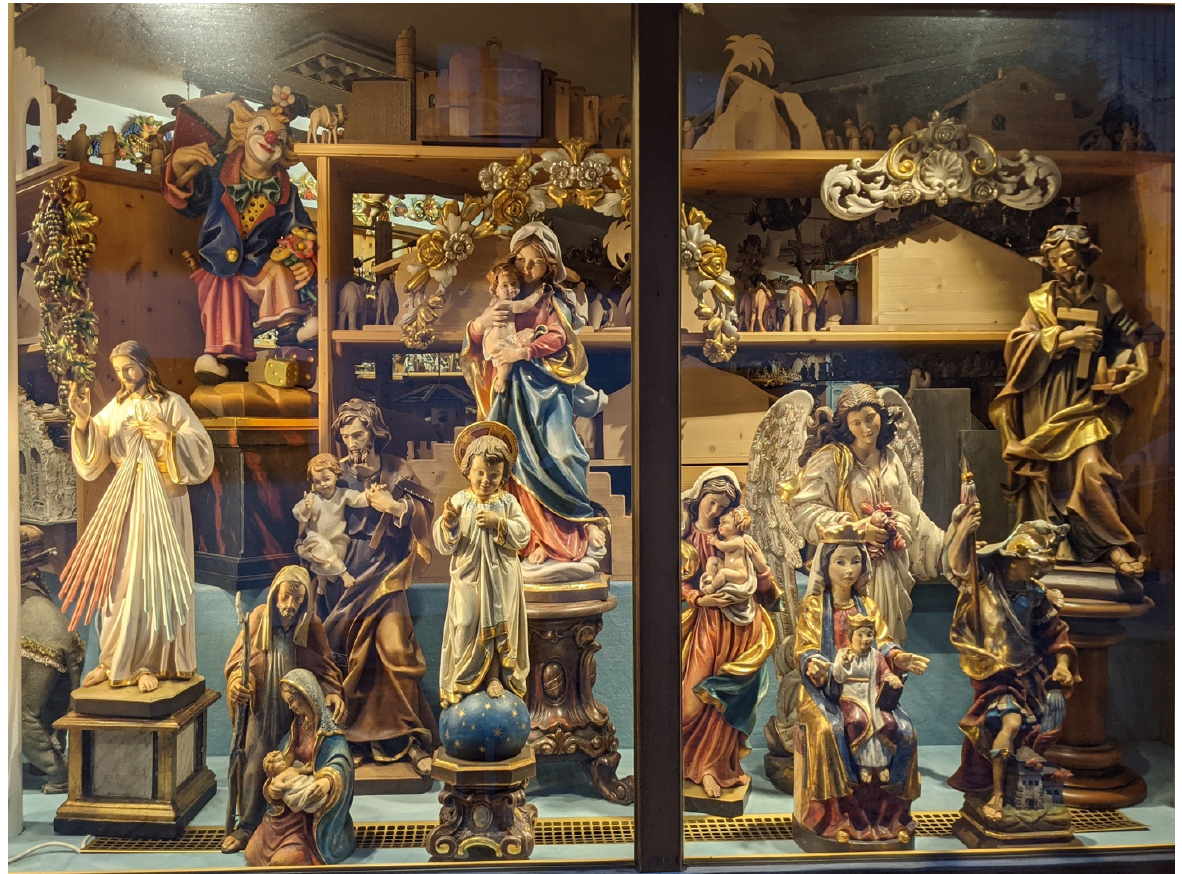
Figure 4. Window of a carver’s shop in Oberammergau. Photograph by the authors.